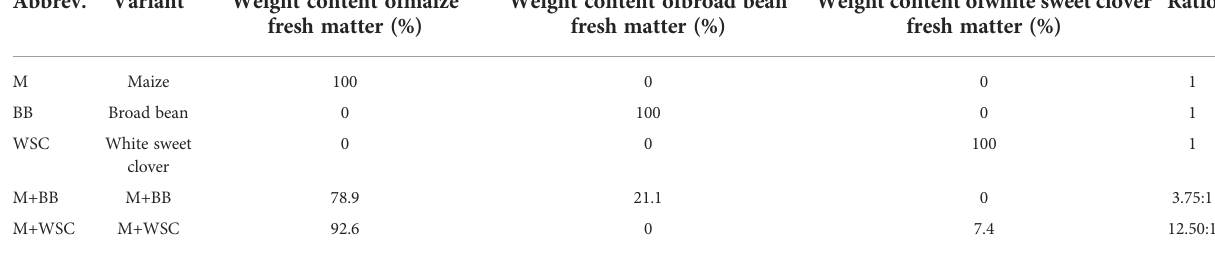
TABLE 1 Prepared model silages.